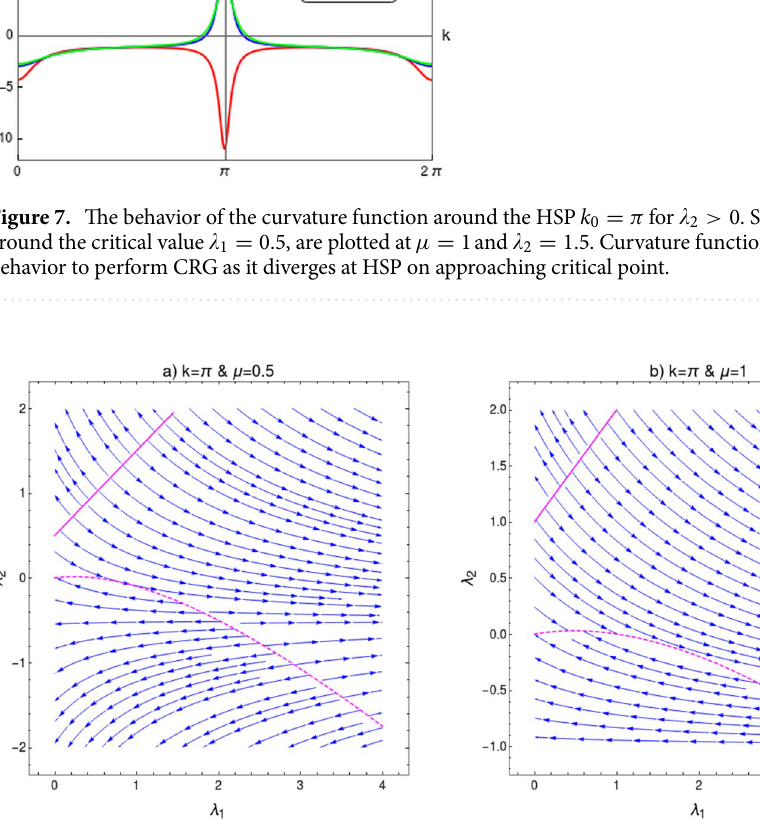
0.5 and ( b ) µ 1 . The RG flow directions are = =